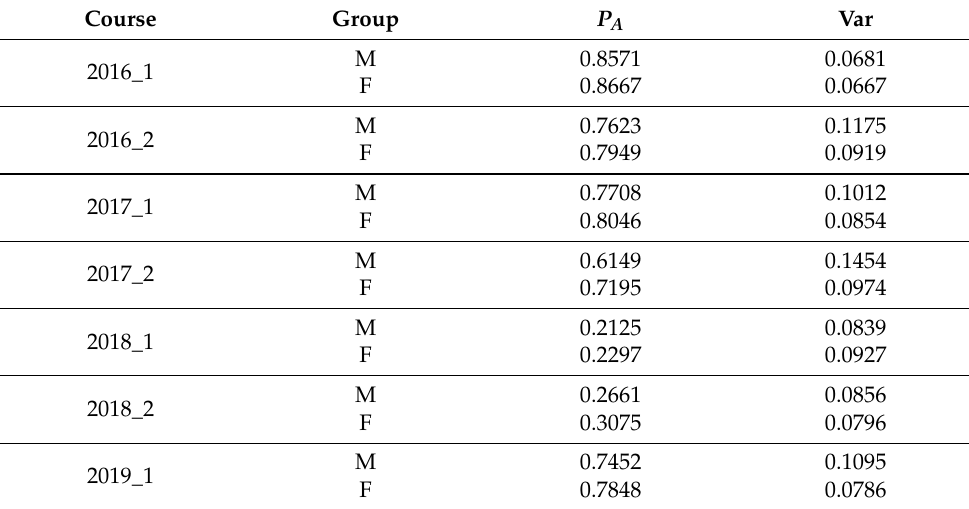
Table 5. Academic performance indicator values by semester and